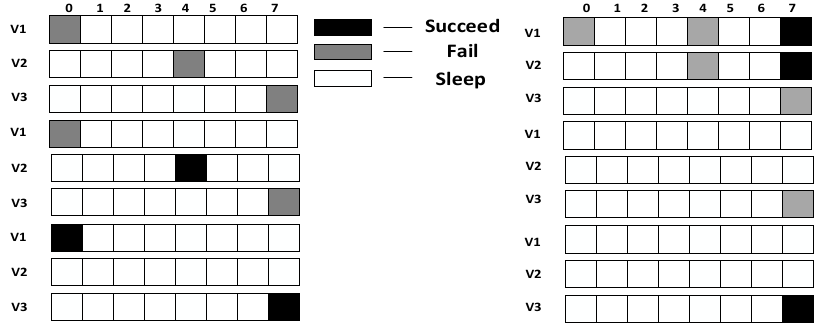
Figure 3. Traditional diffusion scheme ( left ) and IFAS ( right ).